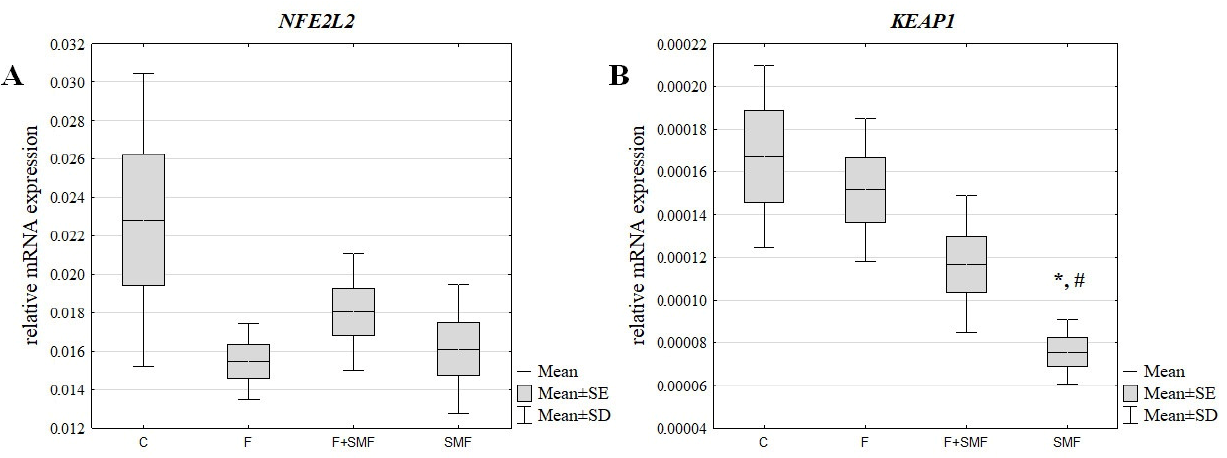
Figure 1. Relative mRNA expression of the NFE2L2 ( A ) and KEAP1 ( B ) genes in cells that had been treated with fluoride and cells that had been exposed to a static magnetic field. The results are presented as the mean ± SD; C—control cells; F—cells that had only been treated with fluoride; SMF—cells that had only been exposed to a static magnetic field; F + SMF—cells that had simultane- ously been exposed to fluoride and a static magnetic field; * p < 0.05 vs. C, # p < 0.05 vs. F. Table 2. Comparison of the gene expression levels (fold change) among the studied cell groups.